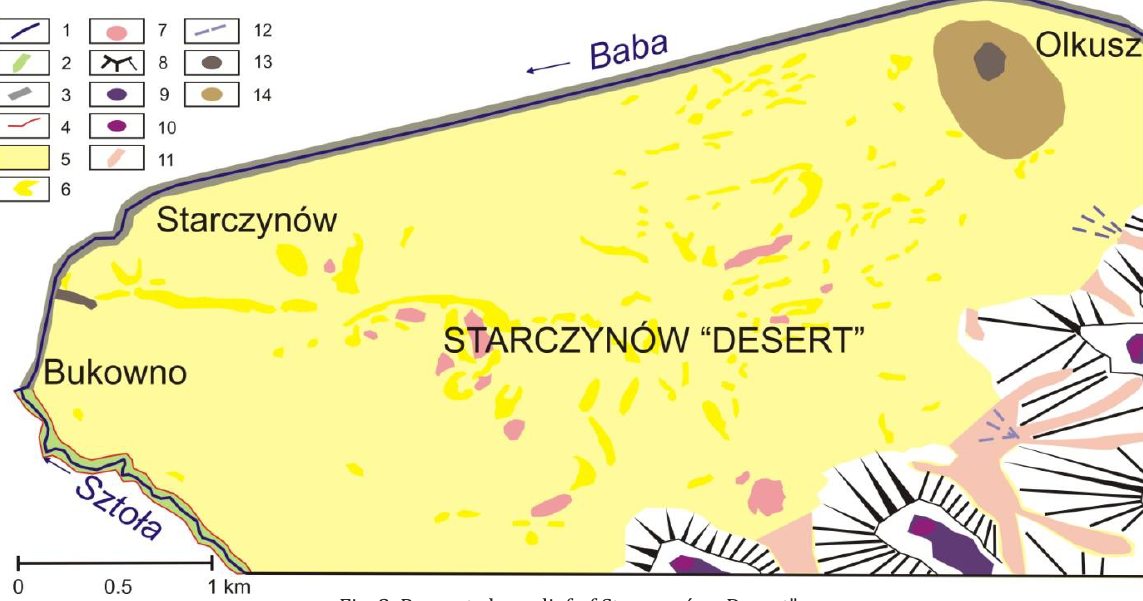
Fig. 2. Present-day relief of Starczynów